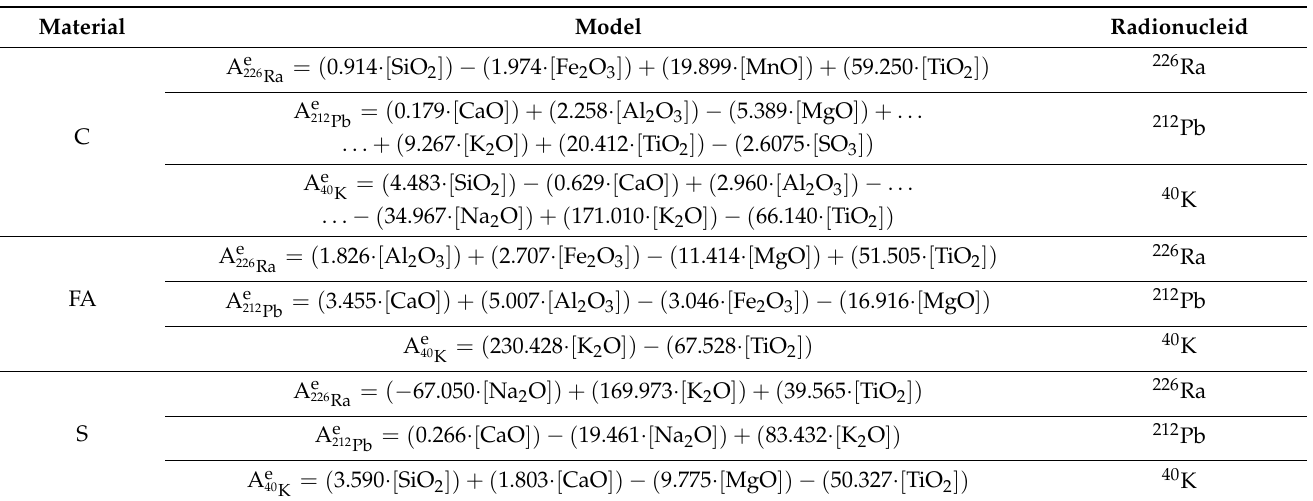
Table 1. Models established to determine the activity concentration of 226 Ra, 212 Pb, and 40 K in C, FA, and S from their chemical